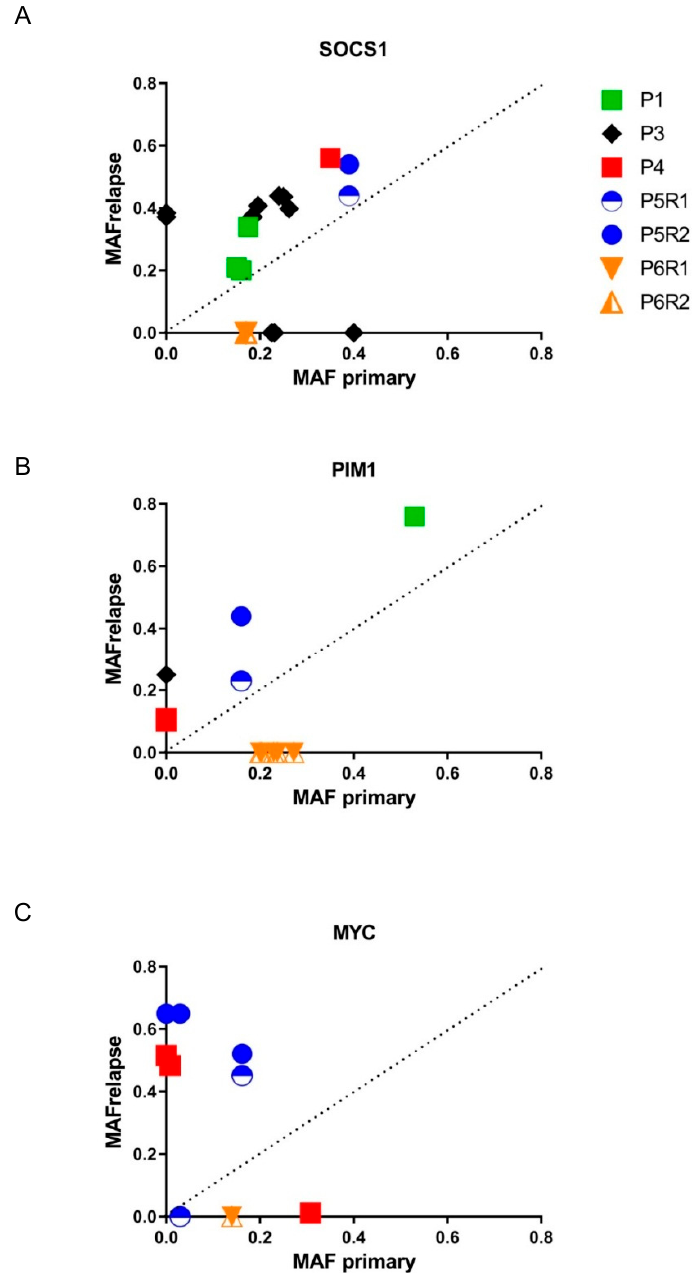
Figure 3. Graphical representation of mutant allele frequency (MAF) of ( A ) SOCS1 , ( B ) PIM1 , and ( C ) MYC in paired biopsies. Mutations above the dashed line are considered as possibly related to therapy resistance. The MAF of SOCS1 mutations remains relatively stable. The MAF of mutations in PIM1 and MYC had at least a two-fold increase in 2 of 5 and 2 of 3 patients, respectively.